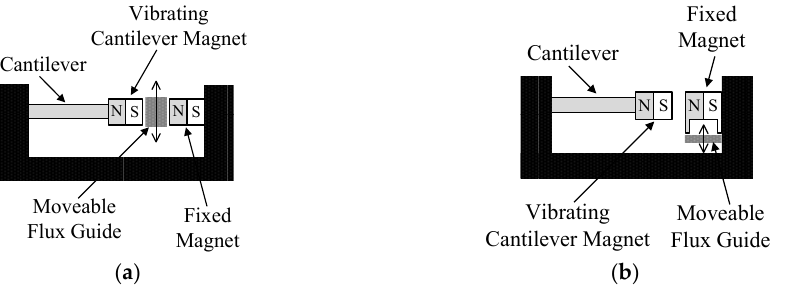
Figure 21. Schematic representations of the variable reluctance based MTT proposed in [39]. ( a ) The flux guide is placed between the two magnets; ( b ) the flux guide is placed between the poles of the fixed